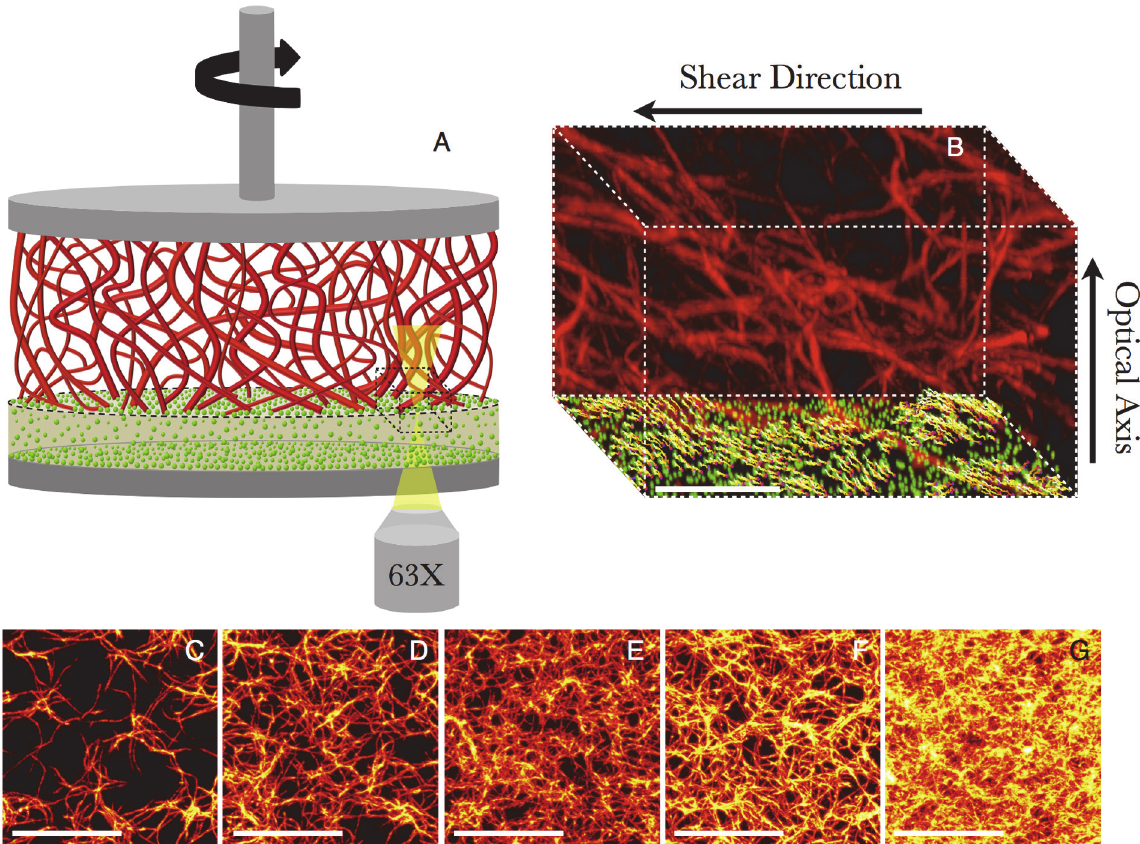
Fig 1. Confocal Rheology system and Type-I collagen morphology for all concentraions. (A) An illustration of a collagen network ( red ) adhered to a PAA gel substrate ( tan ) embedded with fluorescent microspheres ( green ) enclosed in a confocal-rheometer ( gray ). Microspheres embedded at the interface ( dotted circle ) are imaged and tracked for calculation of boundary stresses. (Figure not drawn to scale.) A portion of the confocal volume ( dotted box ) is shown in (B), with fluorescently-labeled collagen (concentration c = 0.25 mg/mL) and vectors representing the measured microsphere displacements ( γ R = 36%.) Scale bar = 25 μ m. (C)-(G) Confocal fluorescence images of collagen networks for concentrations c = {0.25, 0.50, 0.75, 1.0, 1.5}mg/mL and mesh sizes ξ = {12.1 ± 1.0, 6.9 ± 0.9, 4.8 ± 1.0, 3.8 ± 1.0, 2.2 ± 0.7} μ m. Each image is a 10- μ m-thick maximum-projection along the optical axis of the collagen network (cid:4) 20 μ m above the PAA gel surface. Scale bar = 25 μ m.